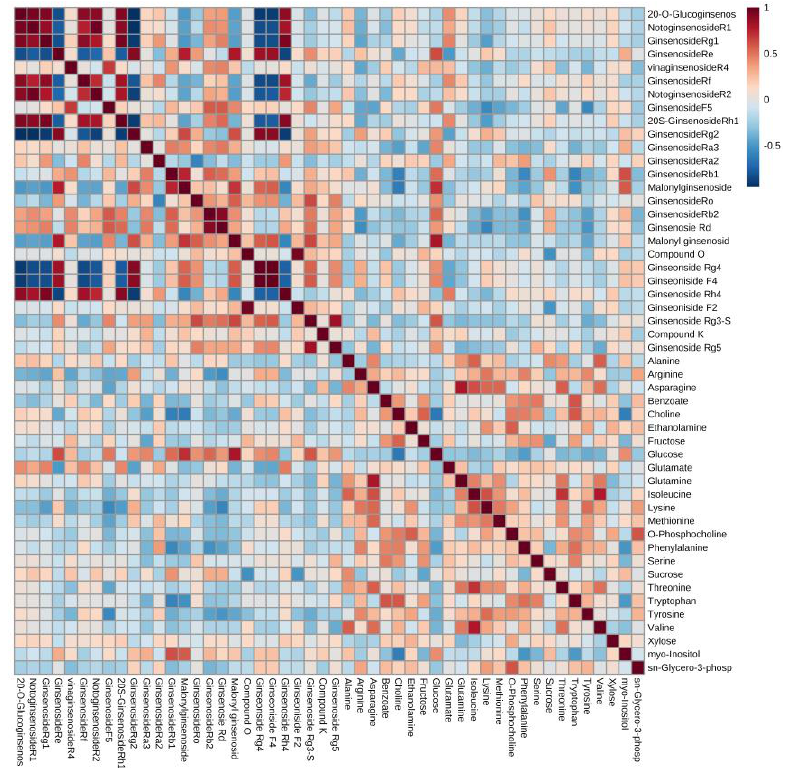
Figure 6. Correlation matrix of primary metabolites and ginsenosides. The scale bar shows the correlation coefficient from − 1 to